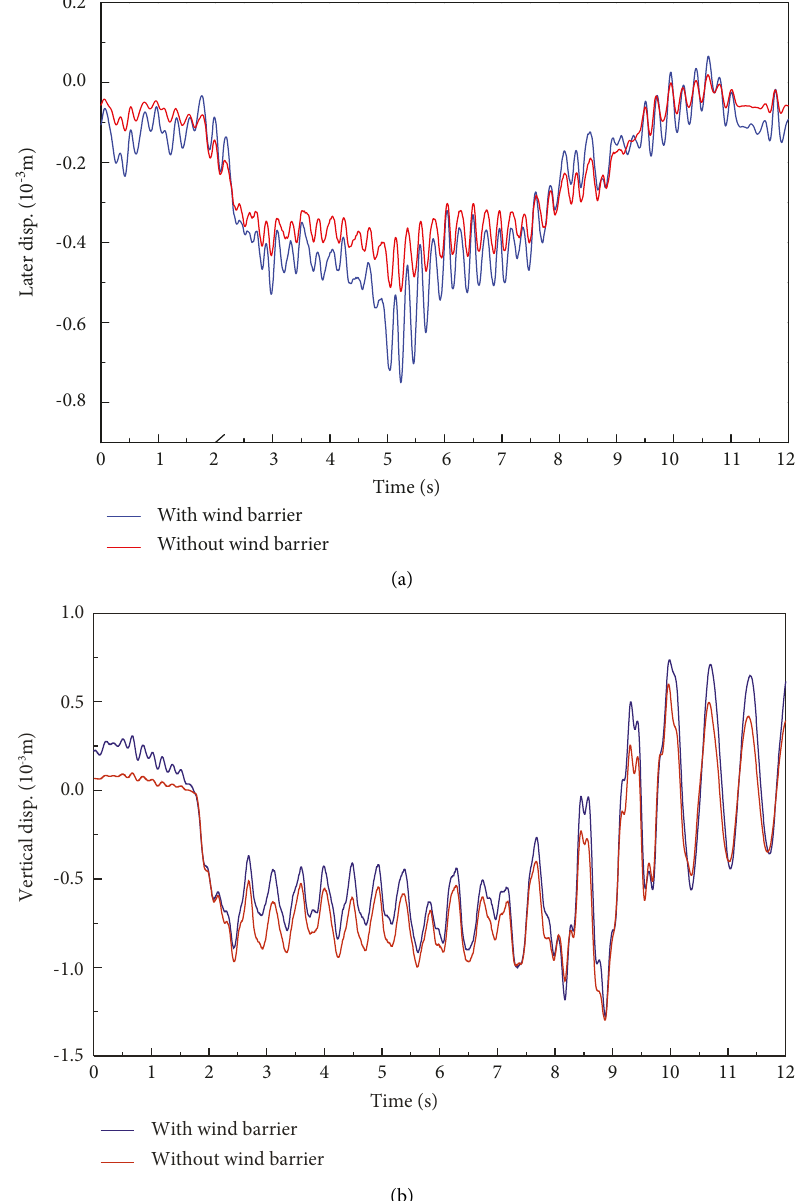
Figure 15: Displacement time histories of node B138 with/without wind barrier. (a) Lateral displacement. (b) Vertical